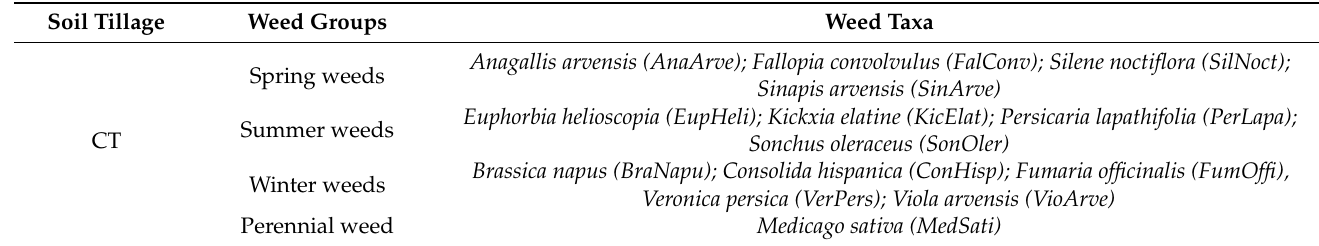
Table 4. Groups of plant species according to CCA